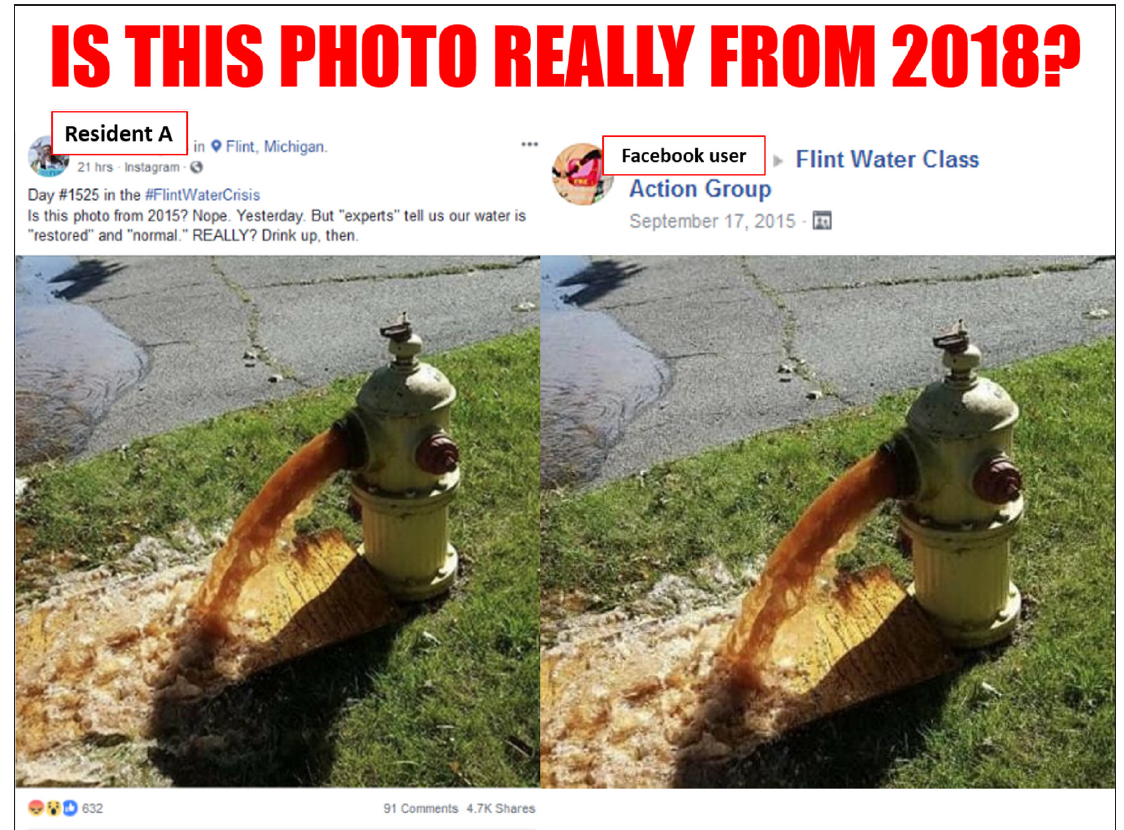
Figure 5: Our online meme comparing Resident A’s fire hydrant photo from June 2018 supposedly showing horrible water (left) compared to the same photo from 2015 taken during the height of the Flint Water Crisis